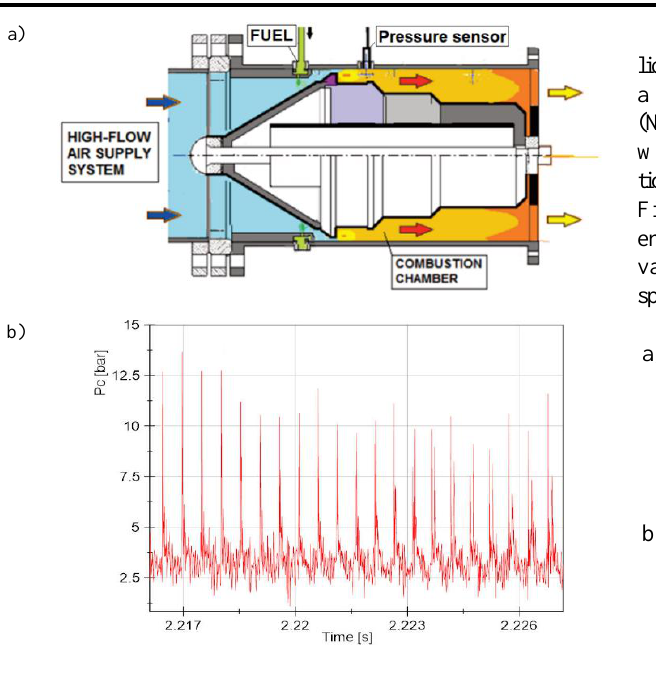
Fig. 8. Schematic diagram of the annular detonation chamber (a) and recorded pressure of the CRD for Jat-A – air mixture (b)